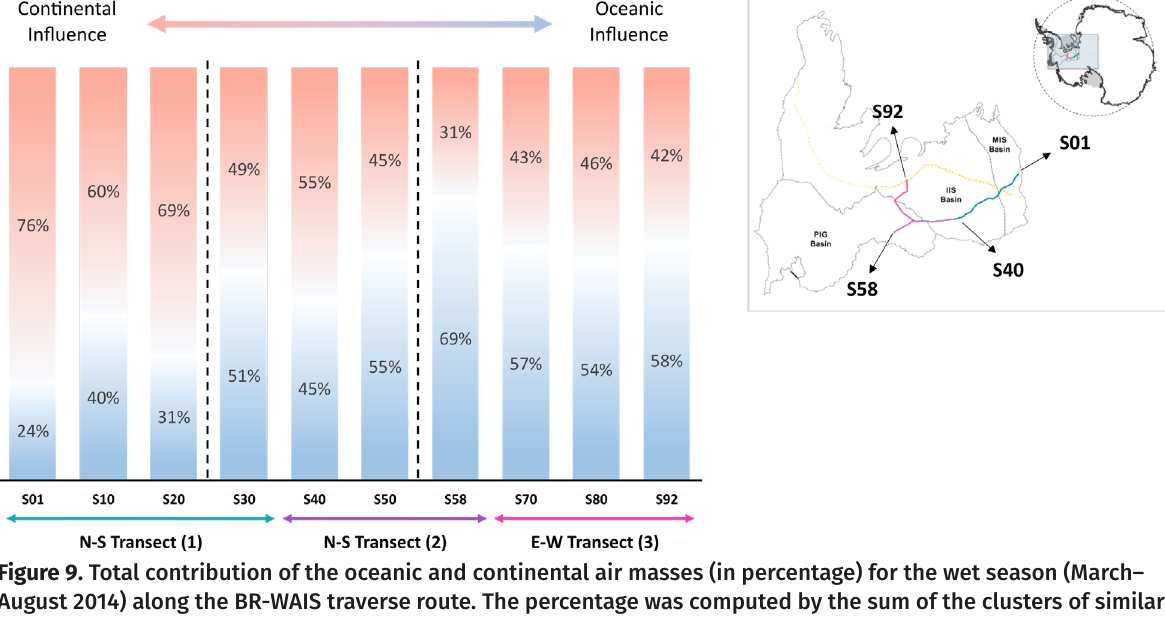
Figure 9. Total contribution of the oceanic and continental air masses (in percentage) for the wet season (March– August 2014) along the BR-WAIS traverse route. The percentage was computed by the sum of the clusters of similar nature ( i.e. , oceanic or continental). The map (on the right) shows the location of the three transects (N-S transect (1), N-S transect (2), and E-W transect (3)) and some samples (S01, S40, S58, S92). Note a transition zone between the S30 and S50 (marked by the dashed